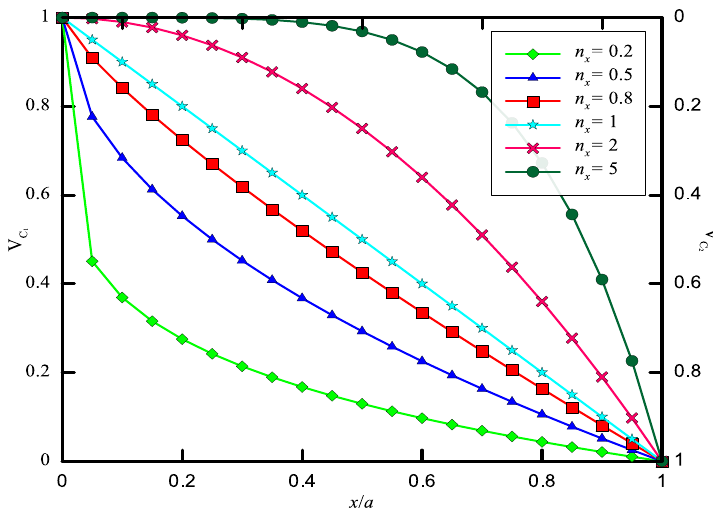
Fig. 3. Through-width volume fraction variation of both C 1 and C 2 material constituents for different values of n x and a value of zero for n z